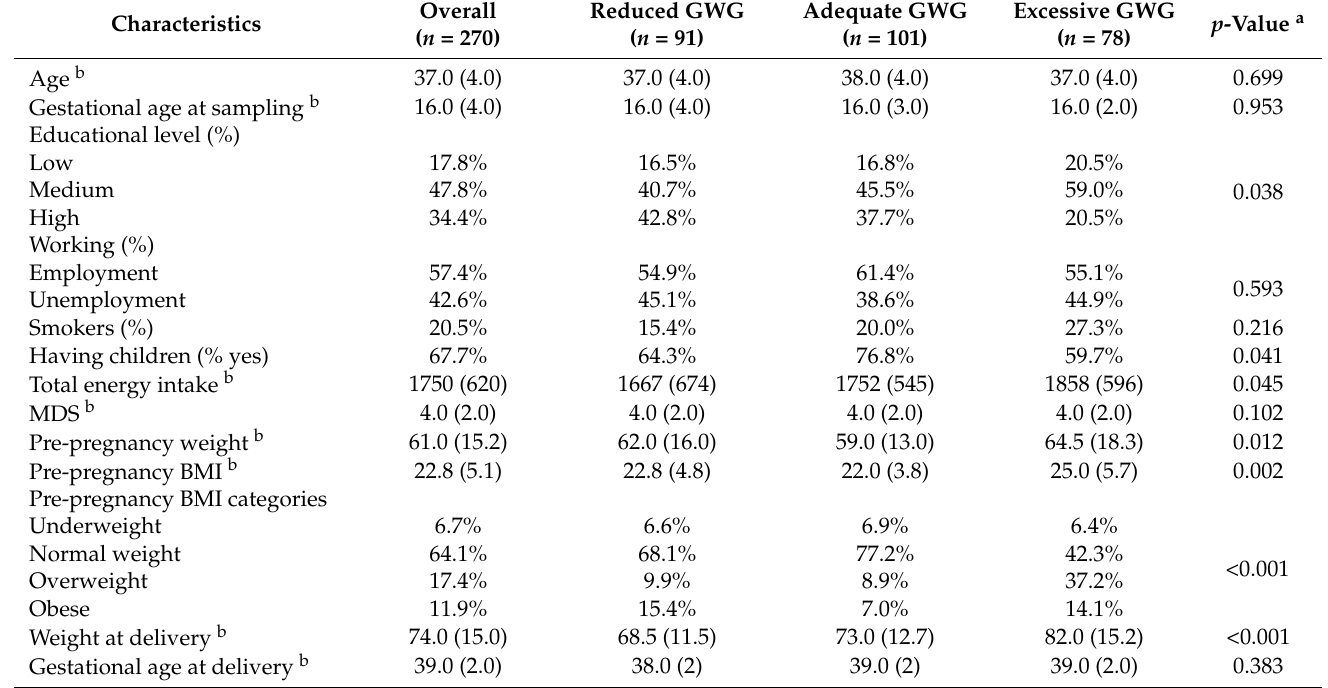
Table 1. Characteristics of women from the “Mamma & Bambino” cohort ( n = 270) according to gestational weight gain